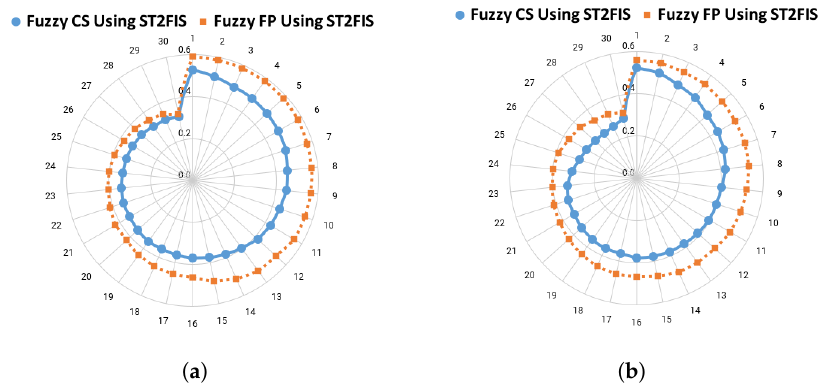
Figure 21. RMSE error comparison for 30 simulations. ( a ) TTCFNLC with actuator fault and noise in the fuzzy controller. ( b ) TTCFNLC with leak fault and noise in the fuzzy controller.